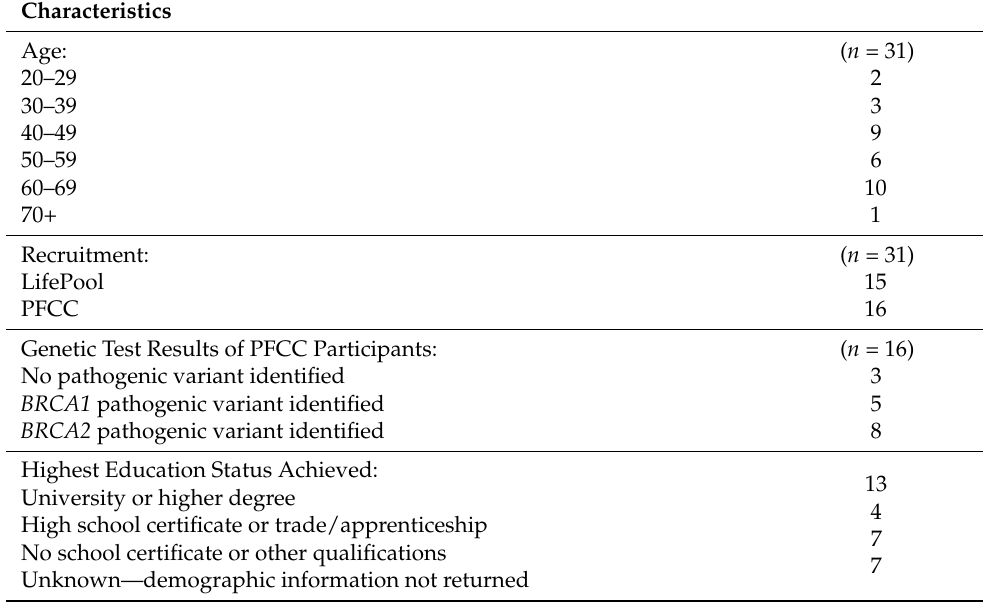
Table 1. Demographic characteristics of participants.